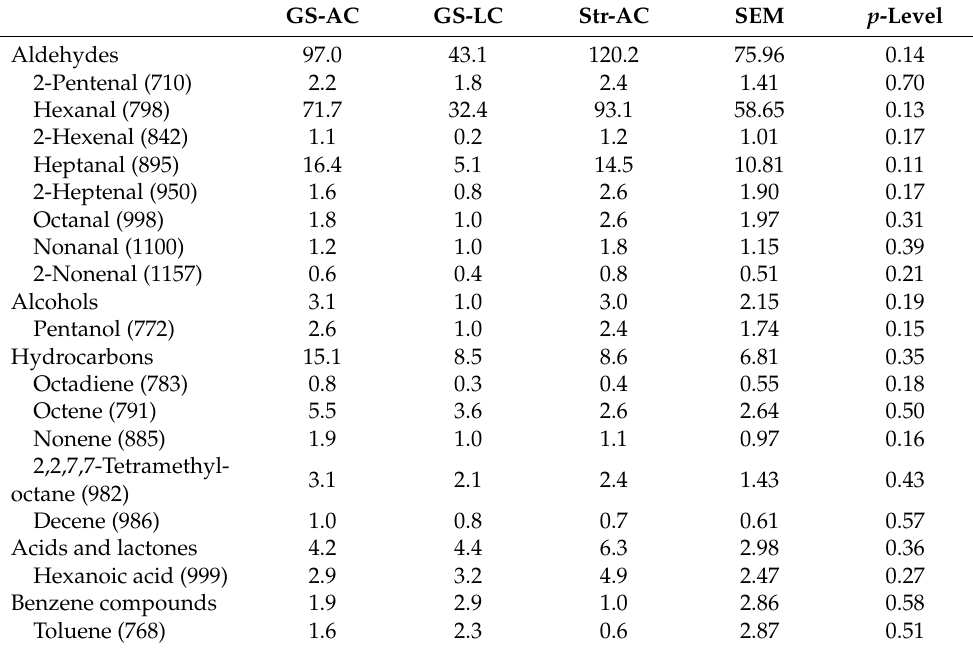
Table 5. Major headspace volatile compounds (ng equivalents of undecane/mL) in the perirenal fat headspace of young Tudanca bulls reared under different feeding systems.